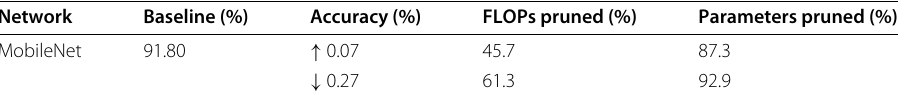
Table 4 Results of pruning MobileNet on